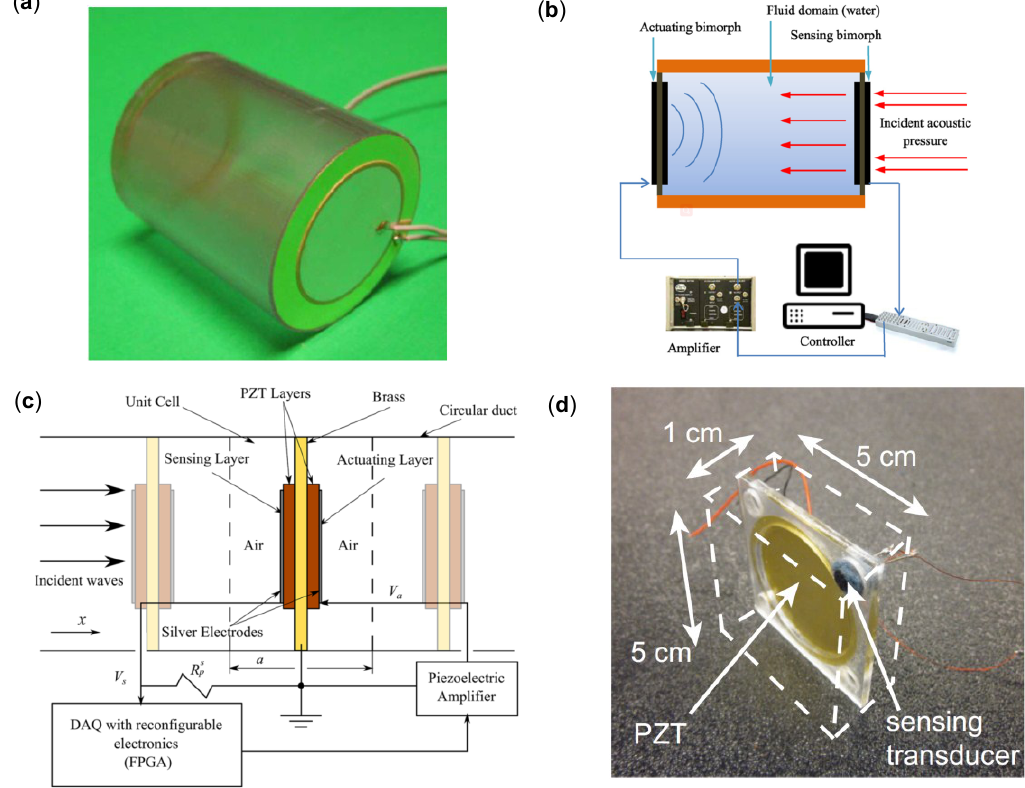
Figure 3. Schematic of ( a ) The active composite sample; ( b ) The operation mechanism of the proposed cell. Adapted with permission from [121], AIP Publishing, 2012. ( c ) The construction of the suggested one-dimensional (1D) acoustic metamaterial (AMM) with one unit cell of the material highlighted. Adapted with permission from [124], AIP Publishing, 2017. ( d ) The active composite sample. Adapted with permission from [126], APS, 2013.